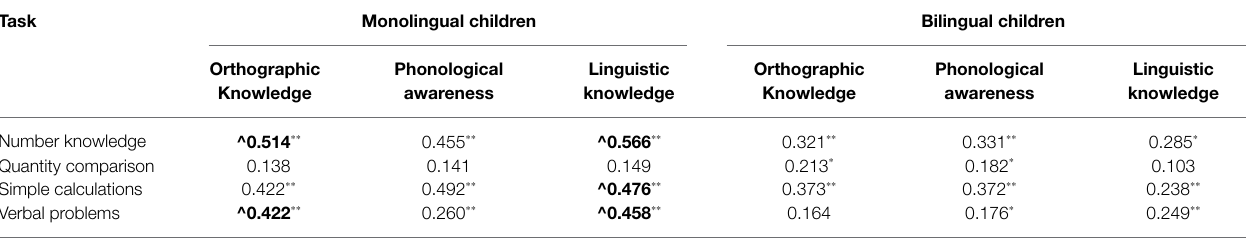
TABLE 5 | Correlation between linguistic and numeric factors among monolingual and bilingual children.